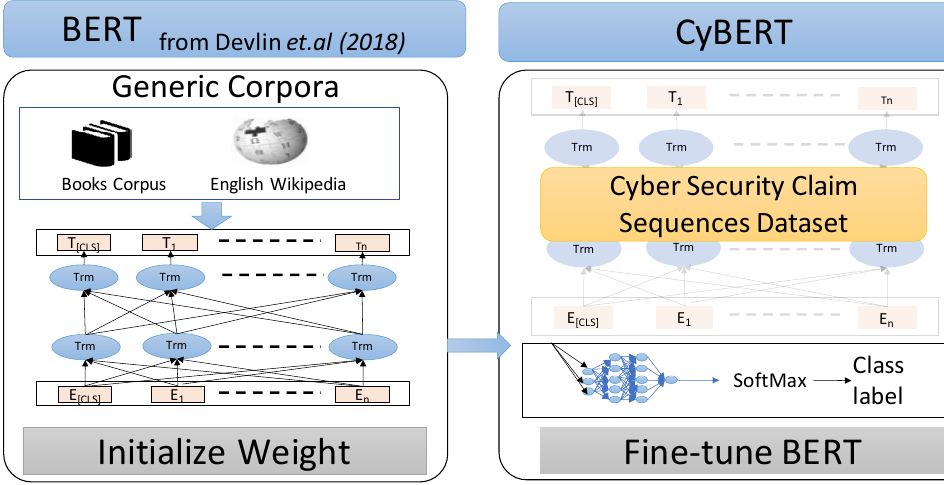
Figure 3. Overview of fine-tuning BERT for